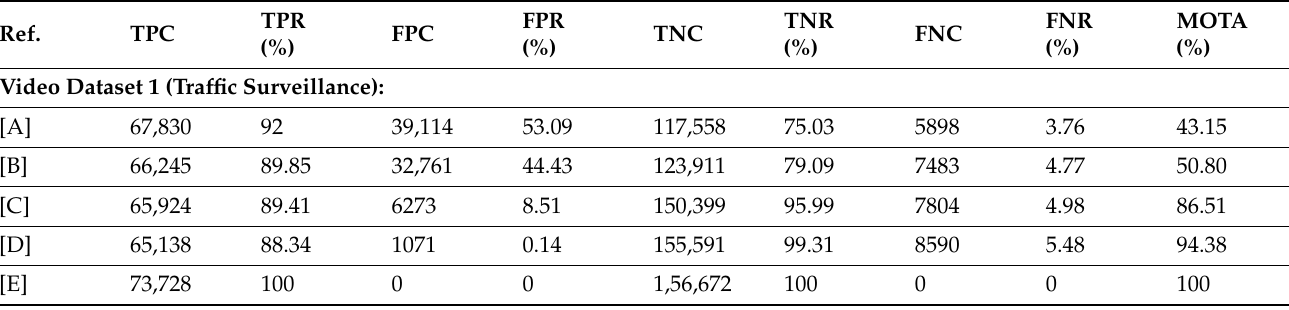
Table 1. Comparison of performance parameters by different approaches tested on video dataset 1: [A] by Pan et al. in [12]; [B] by Mehboob et al. in [13]; [C] by Indu, S. in [14]; [D] our proposed approach; [E] the true data obtained using markers.